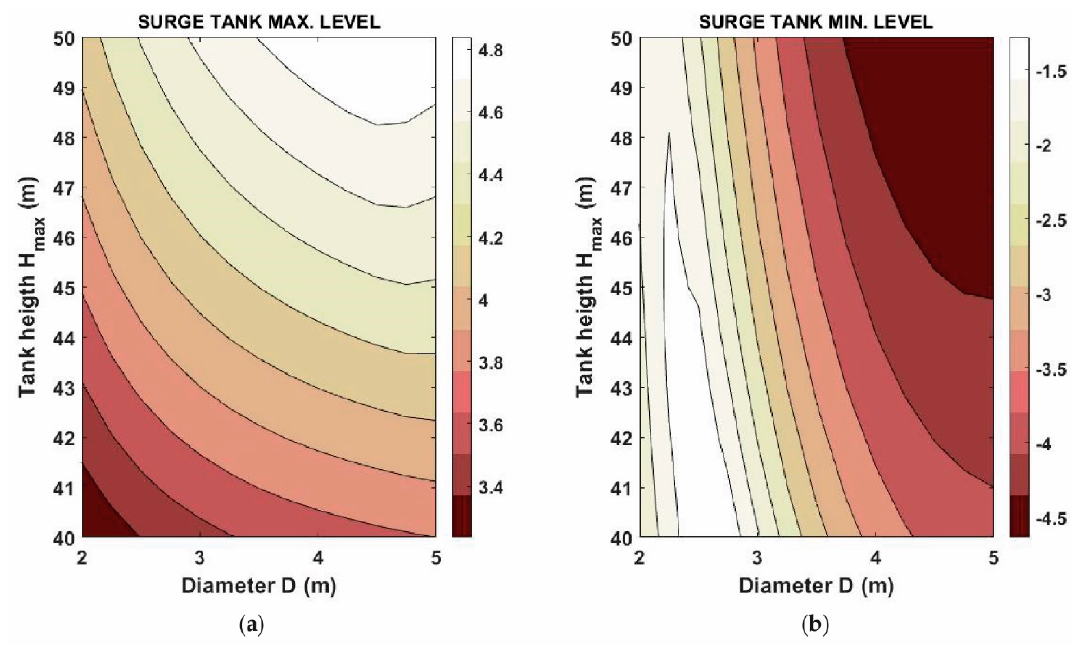
Figure 6. Transient analysis considering a closed surge tank with a diameter between 2–5 m and a height in the 40–50 m range. t c = 10 s. ( a ) Surge tank maximum water level; ( b ) Surge tank minimum water level.